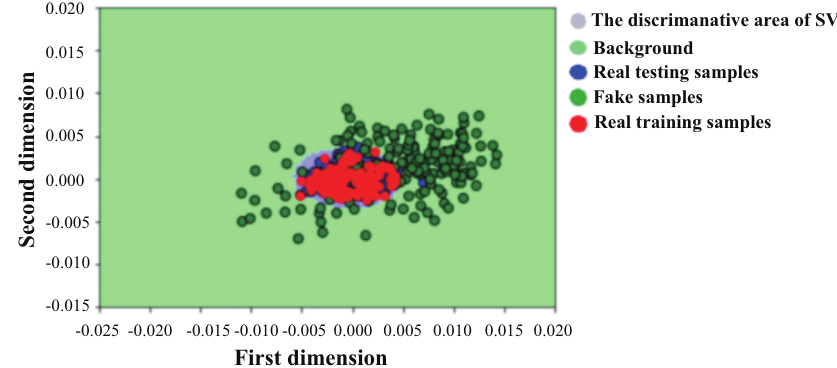
Figure 10. Discriminating space based on the stable GAN.